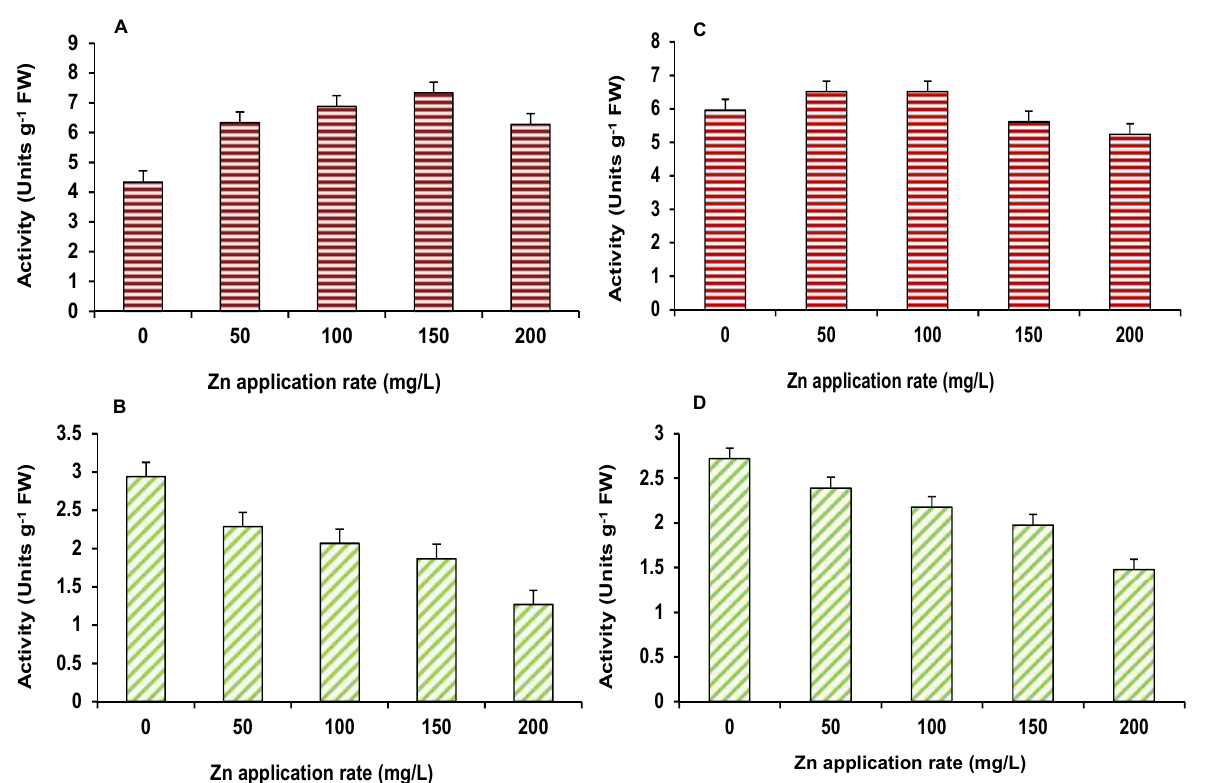
Figure 3. Effect of ZnO NPs treatment on germination related alpha-amylase ( A , C ) and dehydrogenase ( B , D ) activities of maize ( A , B ) and wheat ( C , D ). Values are means of four replicates. Error bars indicate the least significant value (LSD) at p ≤ 0.05 among the treatments.